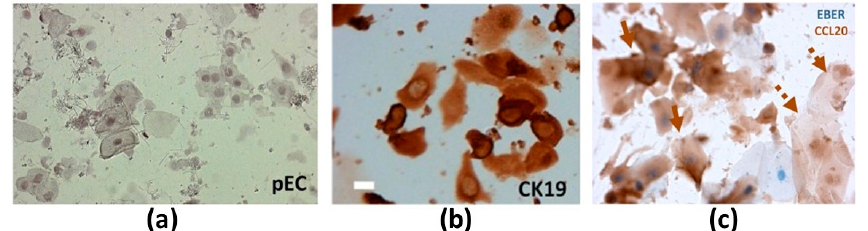
Figure 3. ( a ) EBV-encoded RNA in situ hybridization (EBER-ISH) of periodontal epithelial cells (pECs) and ( b ) chromogenic immunohistochemistry (CIHC) for CK19 (cytokeratin 19; junctional epithelial cell marker) immunostaining of periodontitis samples to reveal EBV-infected ECs. The size bar represents 15 µm. ( c ) EBER-ISH coupled with CIHC of CCL20 (chemokine ligand 20) to show the production of the inflammatory chemokine CCL20 by EBV-infected pECs in periodontitis patients. EBV-infected (solid arrows) and EBV - pECs (dotted arrows) are presented. Reprinted from